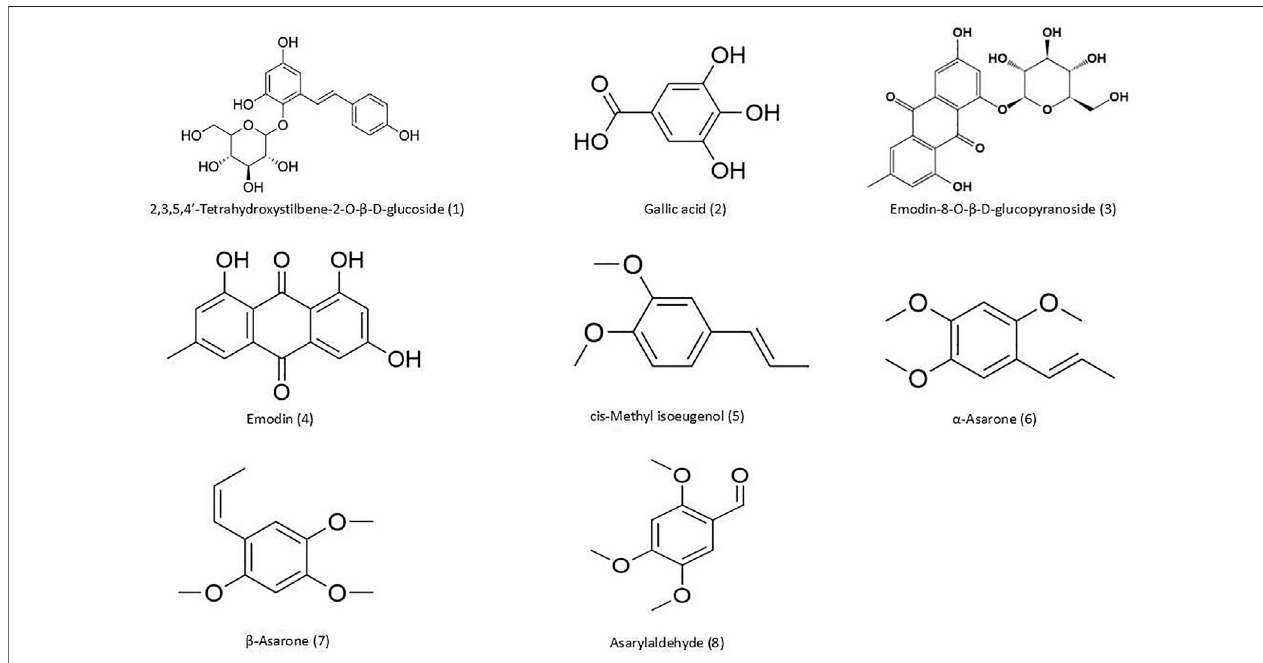
FIGURE 1 | Chemical structures of compounds detected in PA. (1) THSG; (2) gallic acid; (3) emodin-8-O- β - D -glucopyranoside; (4) emodin; (5) cis -methyl isoeugenol; (6) α -asarone; (7) β -asarone; and (8) asarylaldehyde.